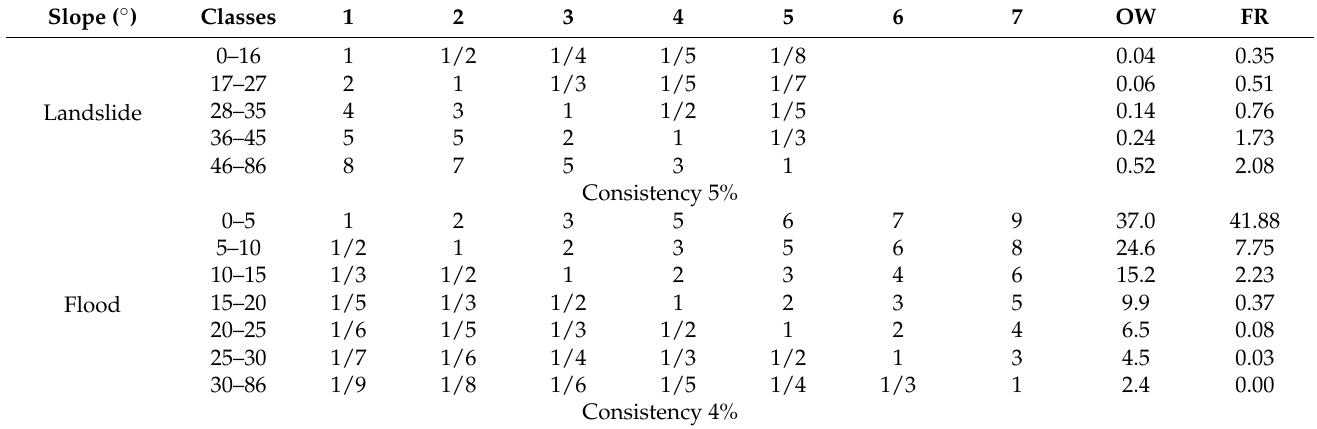
Table 4. AHP matrices and OWs for the slope causative factor classes.